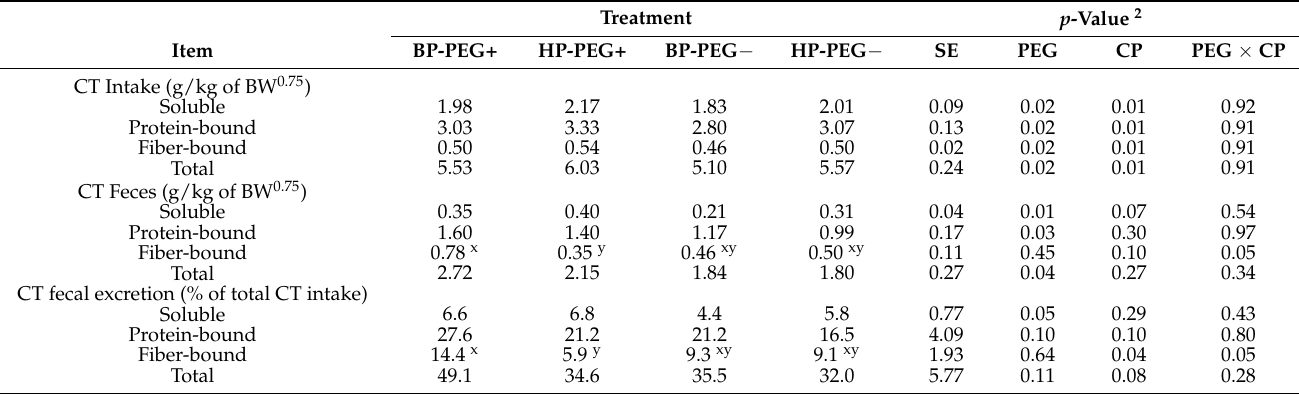
Table 4. Effect of experimental diets on the fecal condensed tannin excretion of lambs over 7 days in experimental period 2 1 . Treatment p -Value 2 Item BP-PEG+ HP-PEG+ BP-PEG − HP-PEG − SE PEG CP PEG × CP CT Intake (g/kg of BW 0.75 ) Soluble